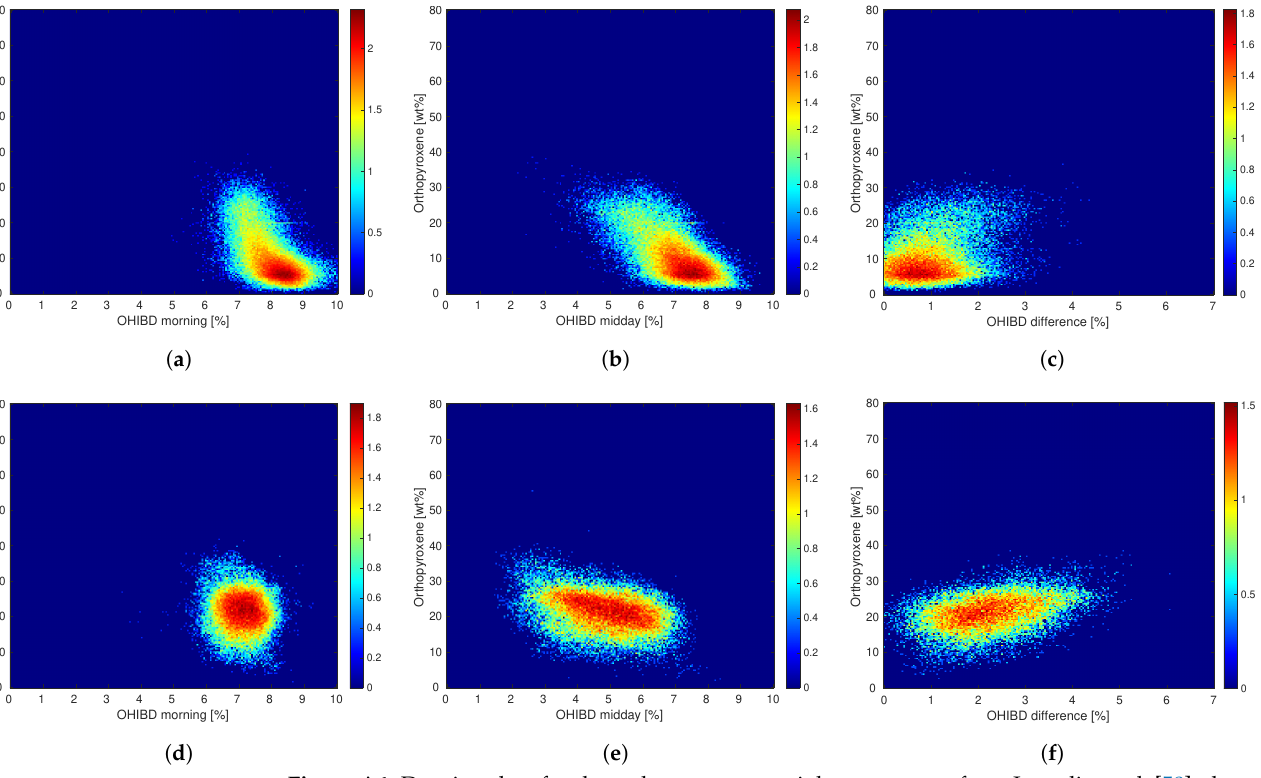
Figure A4. Density plots for the orthopyroxene weight percentage from Lemelin et al. [58] plotted against the OHIBD values at different times of day. The comparison is carried out in the equa- torial mare and highland regions on the lunar near-side. The color bar represents the decadal logarithm of the number of examples at a discrete pixel in parameter space. ( a ) Highland morn- ing ( r = − 0.553), ( b ) Highland midday ( r = − 0.666), ( c ) Highland difference ( r = 0.303), ( d ) Mare morning ( r = − 0.071), ( e ) Mare midday ( r = − 0.360), ( f ) Mare difference ( r = 0.328).